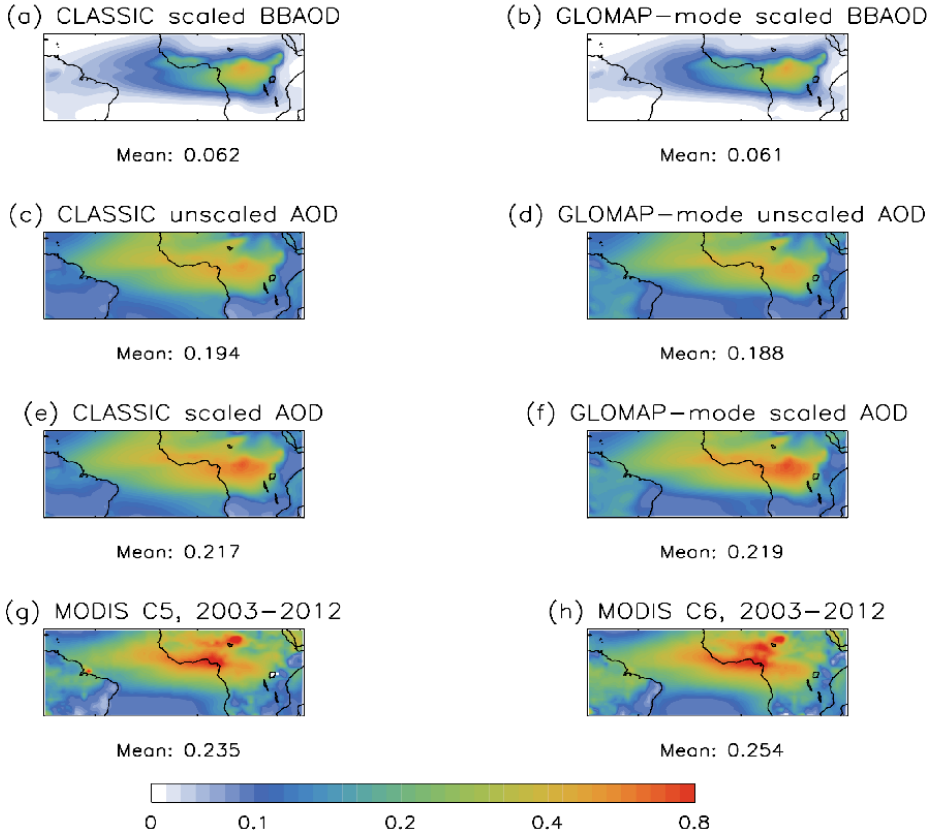
Figure 4. Same as Fig. 2 but for the month of